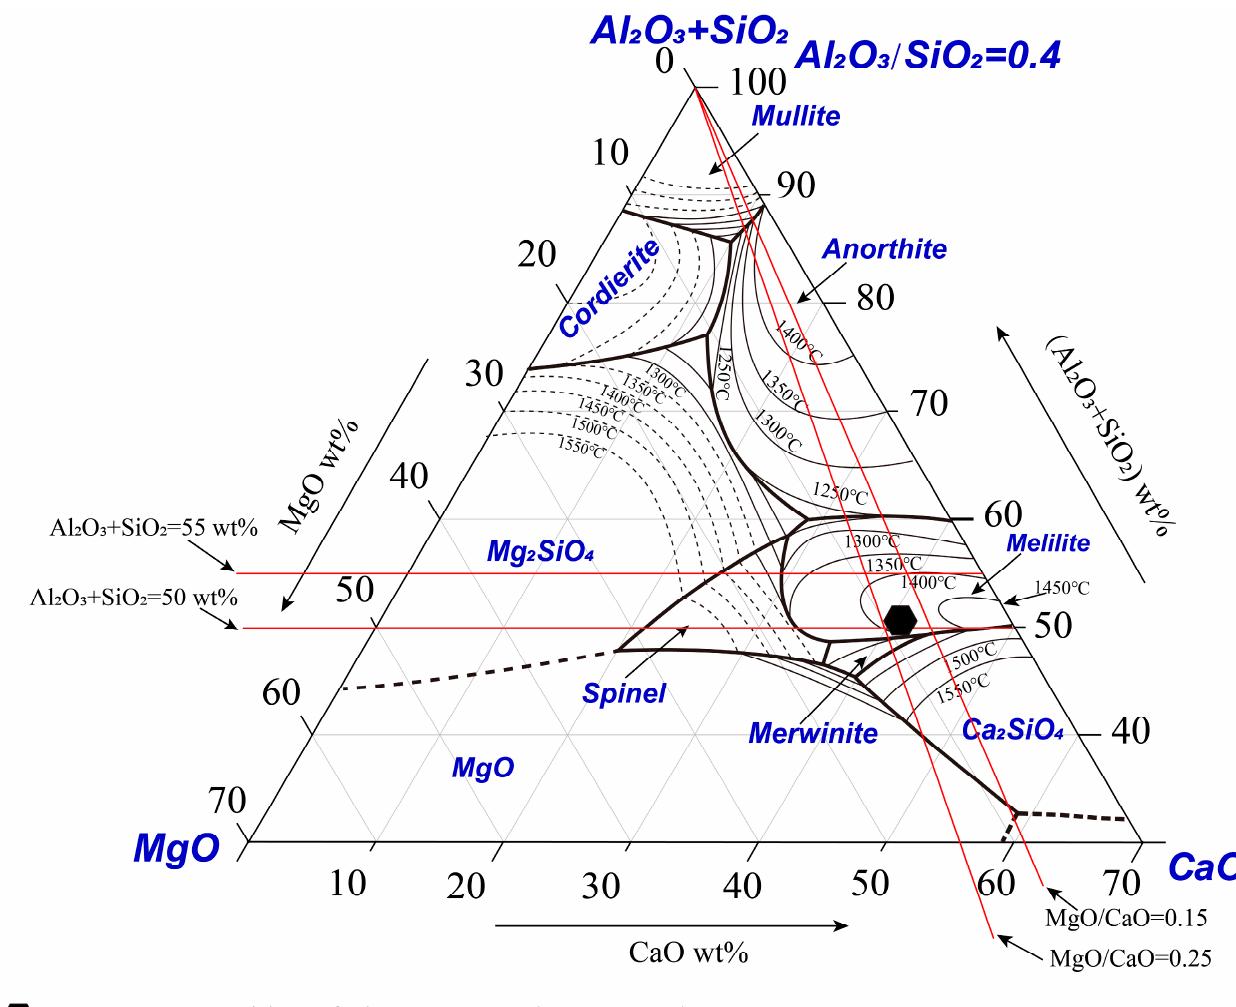
Figure 5. A typical composition of Shougang blast furnace slag [27] and effects of slag composition on the liquidus